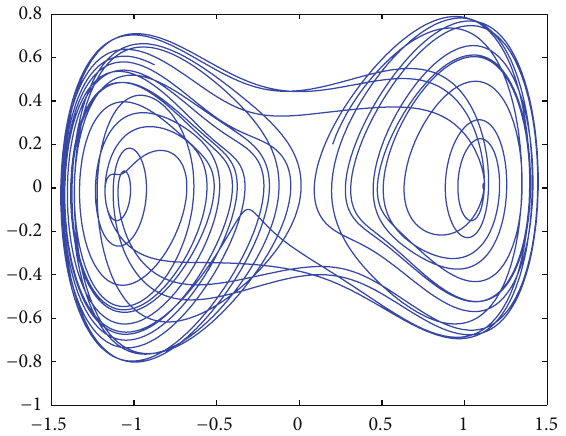
Figure 1: Phase portrait of Duffing-Holmes system (25) with fractional-order 𝑞 = 0.98 .